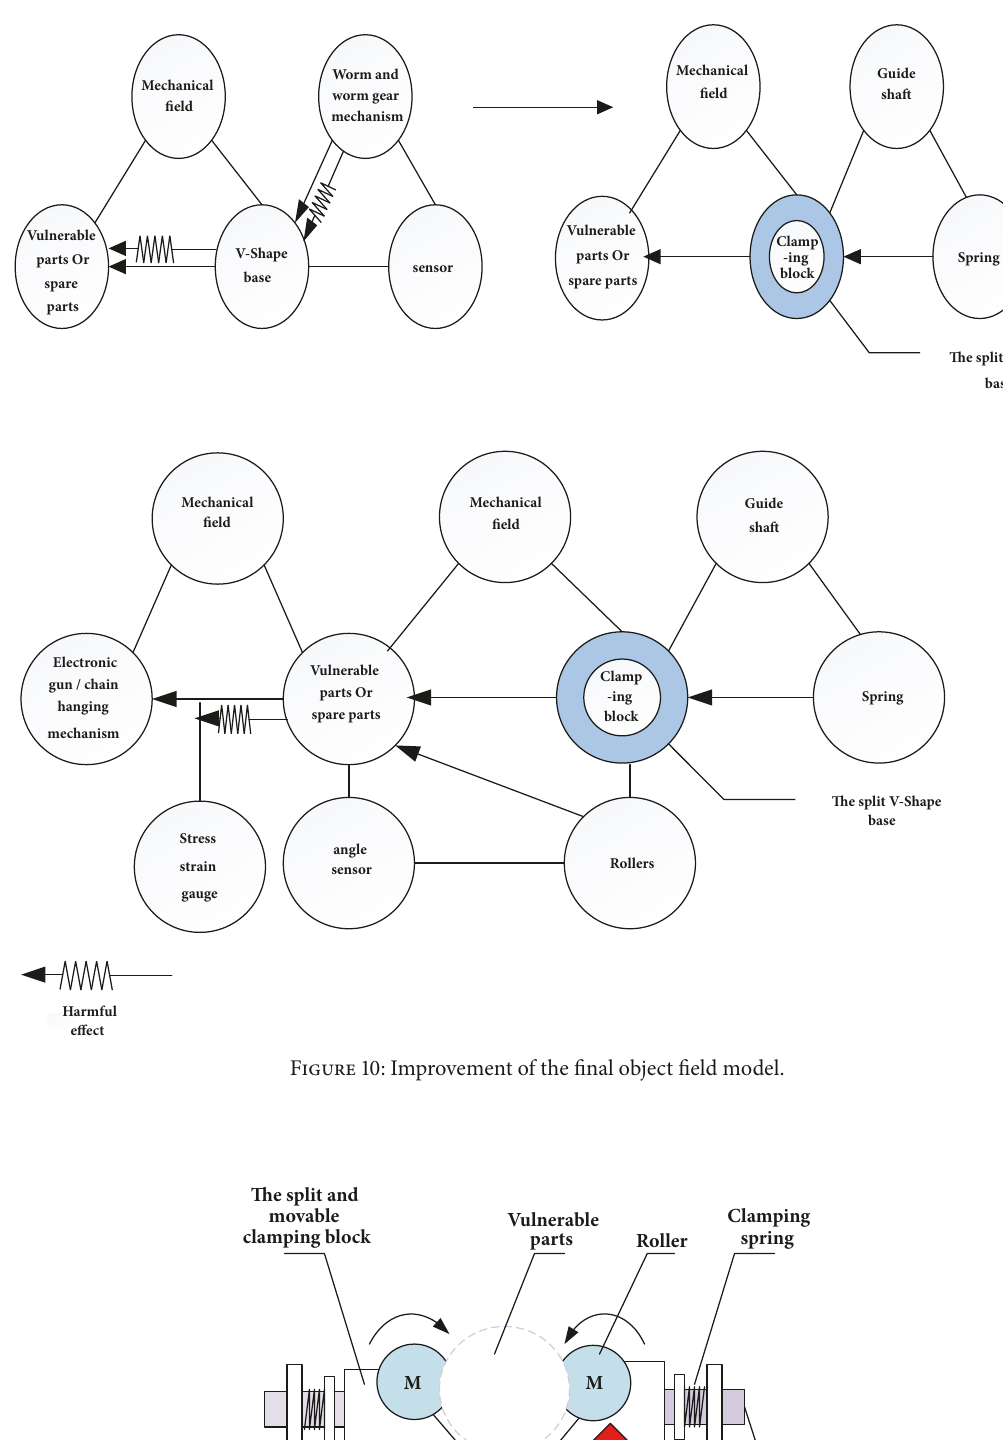
Figure 11: The final schematic diagram of the final